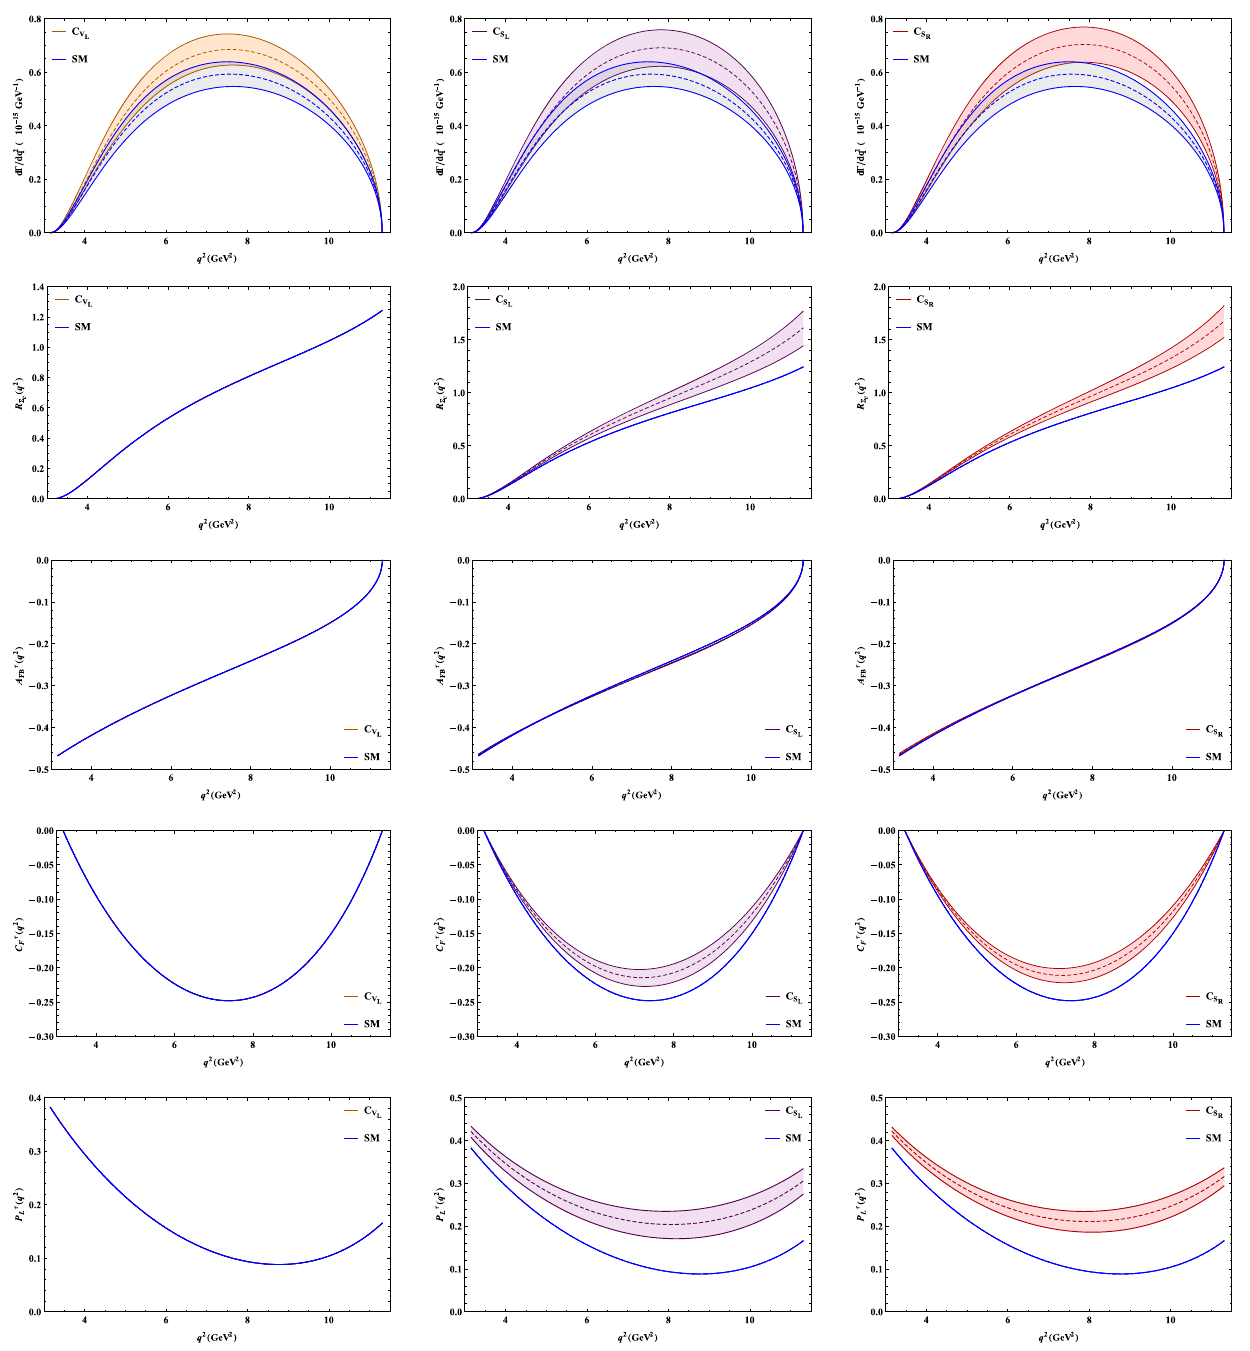
, C ) and scalar ( C S S R ) NP L L